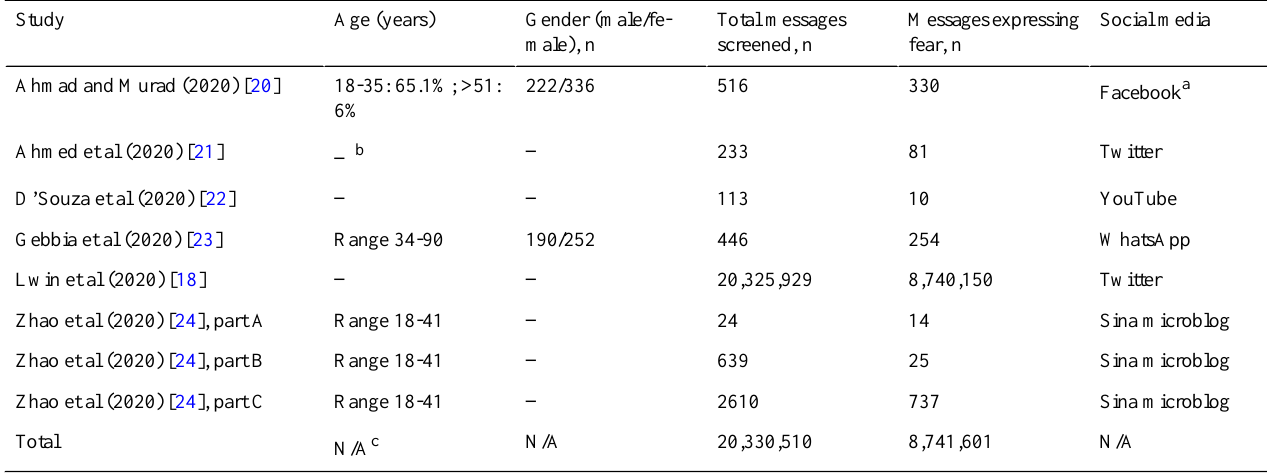
Table 1. Studies